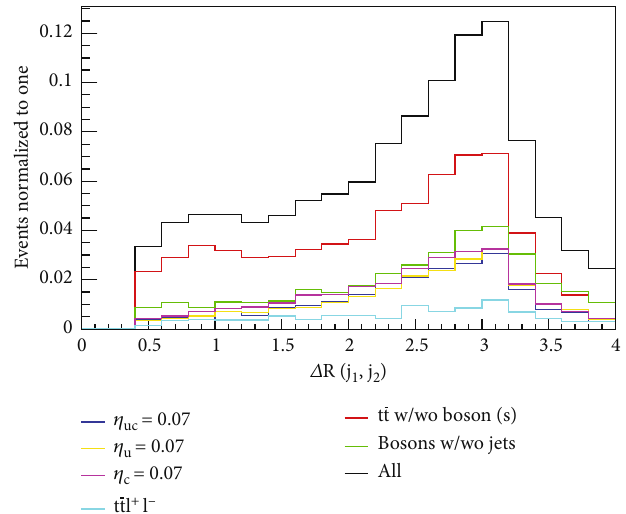
Þ distribution between two jets. Although there is no signi fi cant di ff erence between the signal and background Δ R Figure 17: Δ R ð j , j 1 2 distributions at this point, it stands out as one of the most important variables since the signal process is symmetrical in its stationary frame of reference. Jets have the direct top quarks ’ back-to-back scattering